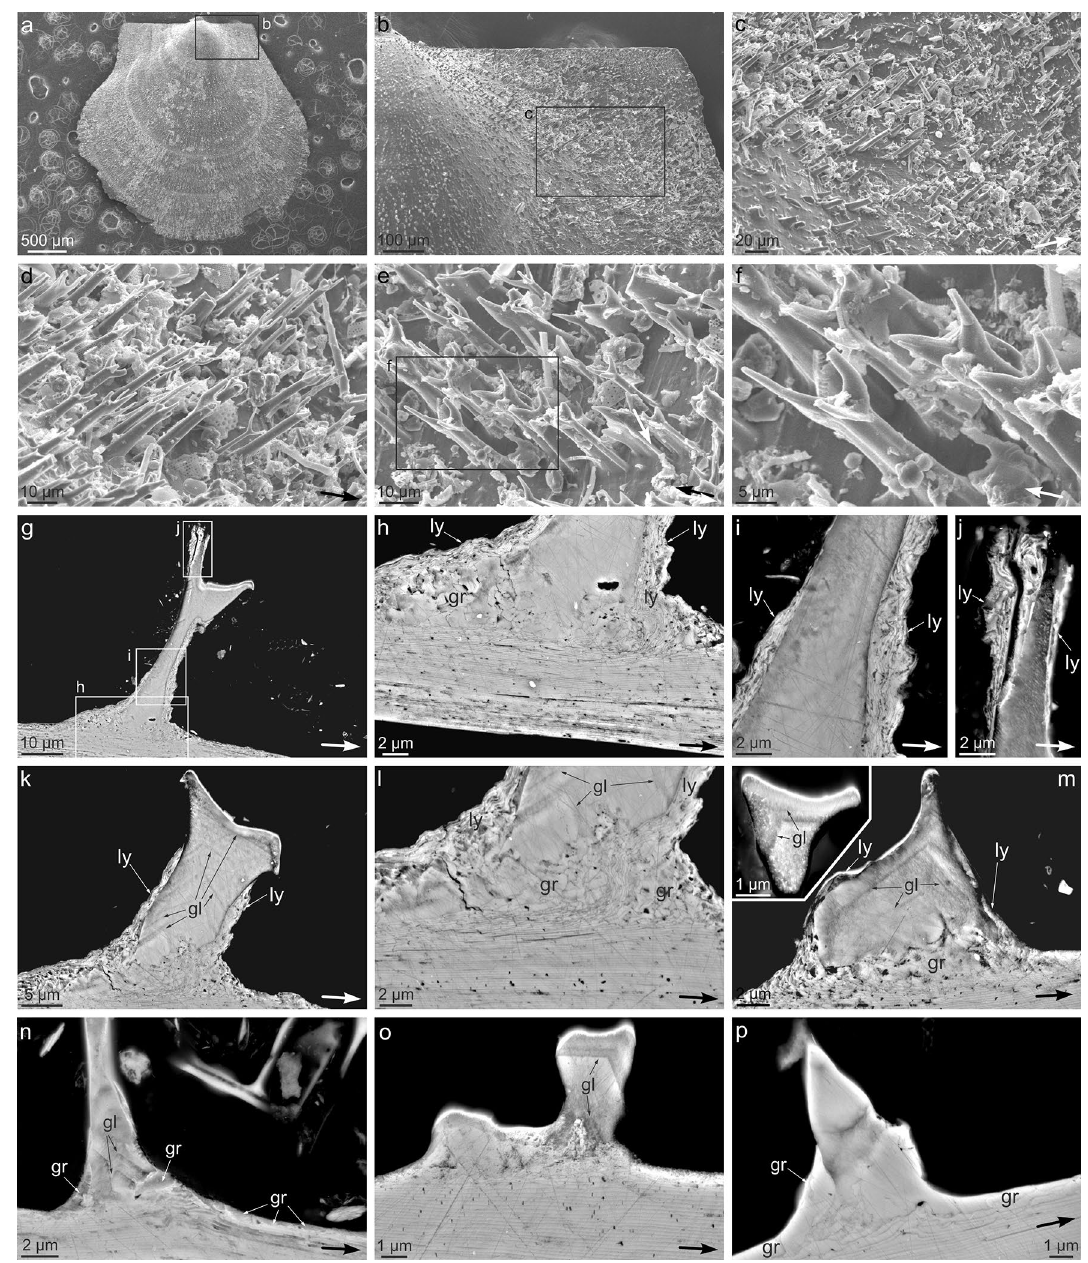
Figure 4. Surface and cross sectional views of the shell and aerials of Catillopecten malyutinae . ( a ) General view of a left valve. ( b ), ( c ) Progressive close ups of the posterior area of a , showing the distribution of aerials. ( d )–( f ) Details of the aerials of the anterior ( d ) and posterior shell areas ( e ), ( f ). Note that there is always a branch pointing in the local growth direction. b , c , and f are close ups of the areas framed in ( a ), ( b ) and ( e ), respectively. The big arrows in c to f indicate the local growth direction of the shell. ( g )–( j ) ( g ) is a general view of an aerial and its insertion within the shell, with indication of the details shown in ( h ) to ( j ) (frames). ( h ) Detail of the contact between the foliated layer and the massive monocrystalline core of the aerial. There are granular (gr) and layered (ly) intervening deposits. ( i ), ( j ) Middle and top parts of the aerial, respectively. Note layered deposits (ly) surrounding the massive monocrystalline core. ( k ) – ( p ) Details of other aerials and their contacts with the foliated shell. There are visible growth lines (gl) in ( k ) to ( o ), lateral layered deposits (ly) in ( k ) to ( m ), and granular deposits (gr) in ( l ) to ( n ) and ( p ). These extend onto the shell surface in ( n ) and ( p ). Arrows in ( g ) to ( p ) indicate the shell growth direction in all cases. Images in ( g ) to ( p ) have been made using the SEM backscatter (CBS)